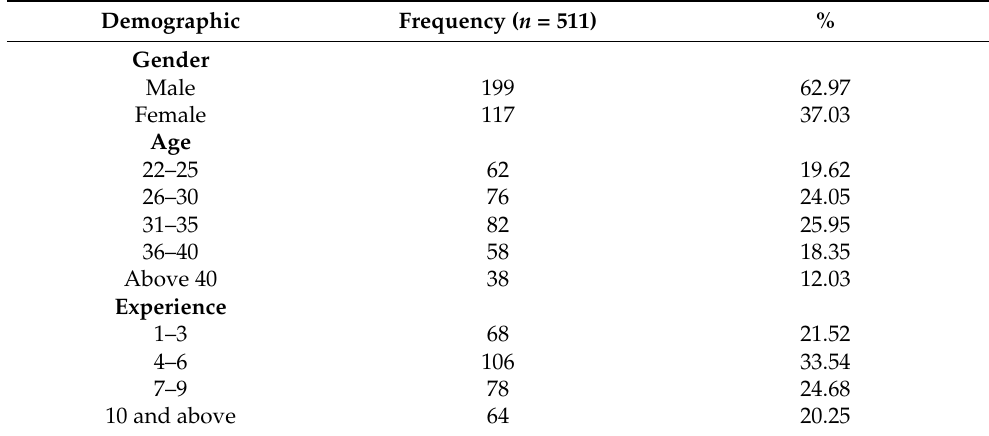
Table 1. Demographic profile of the